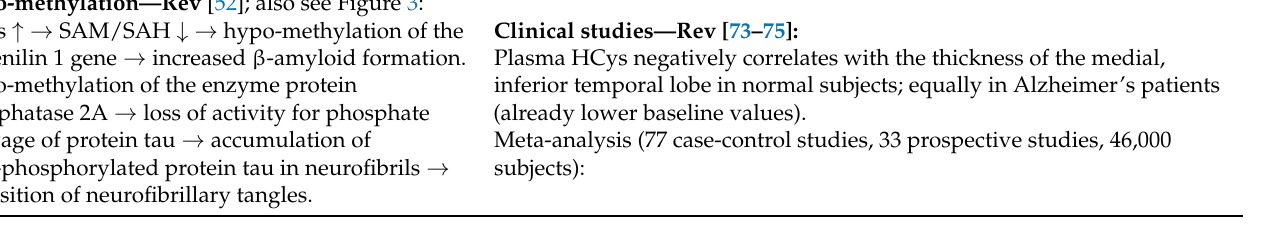
Table 3. Cognitive decline and dementia; left column: relevant HCys-associated pathomechanisms; right column: correlation analyses and information on clinical studies; citation of other reviews or meta-analyses is marked as Rev [citation], followed by the reported findings, without individual